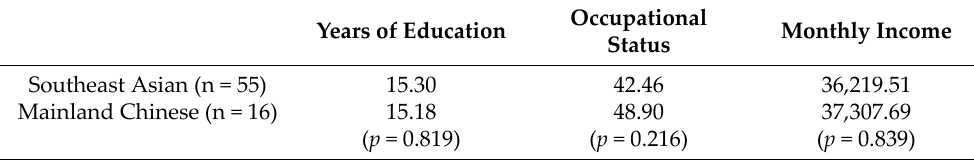
Table 5. Comparisons between children of southeast Asian and mainland Chinese